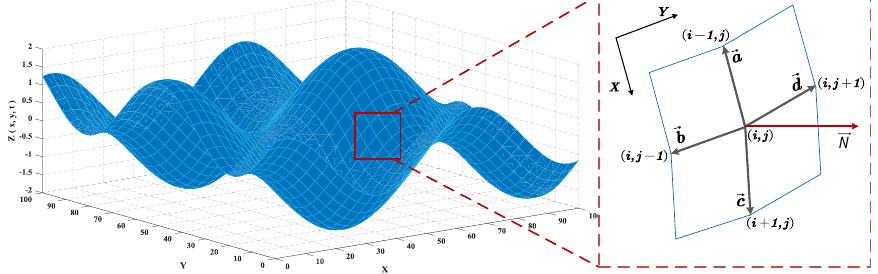
Figure 3. The mesh node and its four surrounding mesh elements.